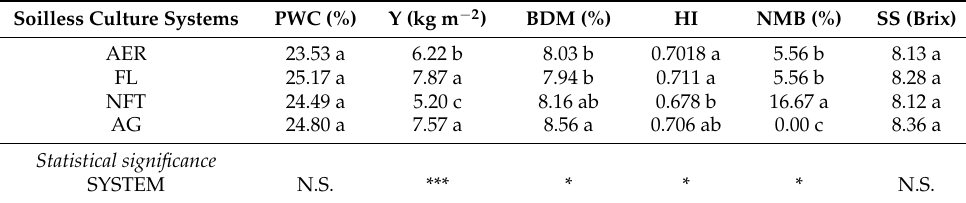
Table 5. Impact of the CSCS on: (i) the % plant weight change prior and after curing (PWC—%); (ii) the yield (Y—kg m − 2 ); (iii) the bulb % dry matter (% BDM); (iv) the harvest index (HI); (v) the % non-marketable bulbs (%) and (vi) the soluble solids